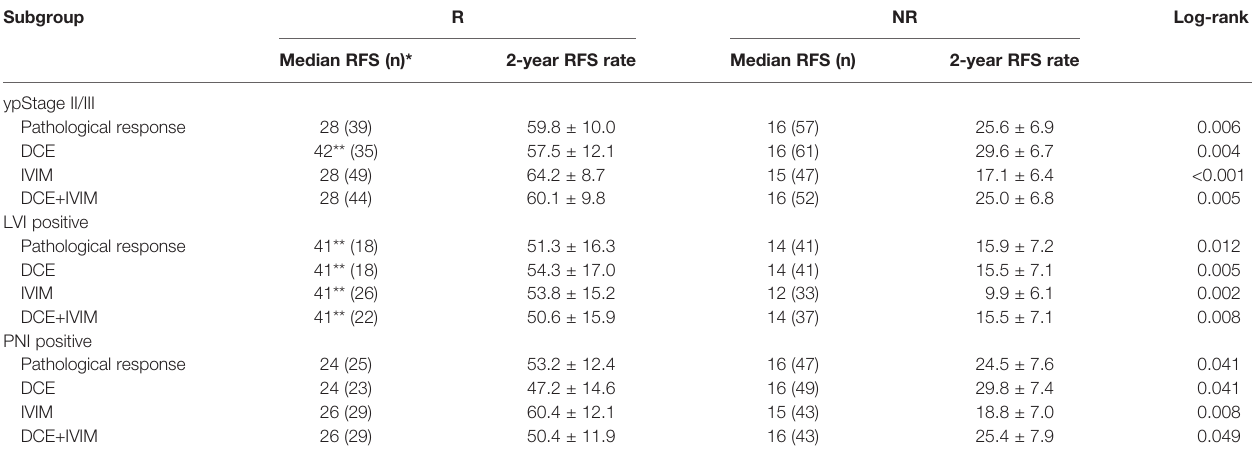
TABLE 8 | Subgroup Kaplan – Meier survival analysis of RFS according to response grouped by pathology and prediction models. Subgroup